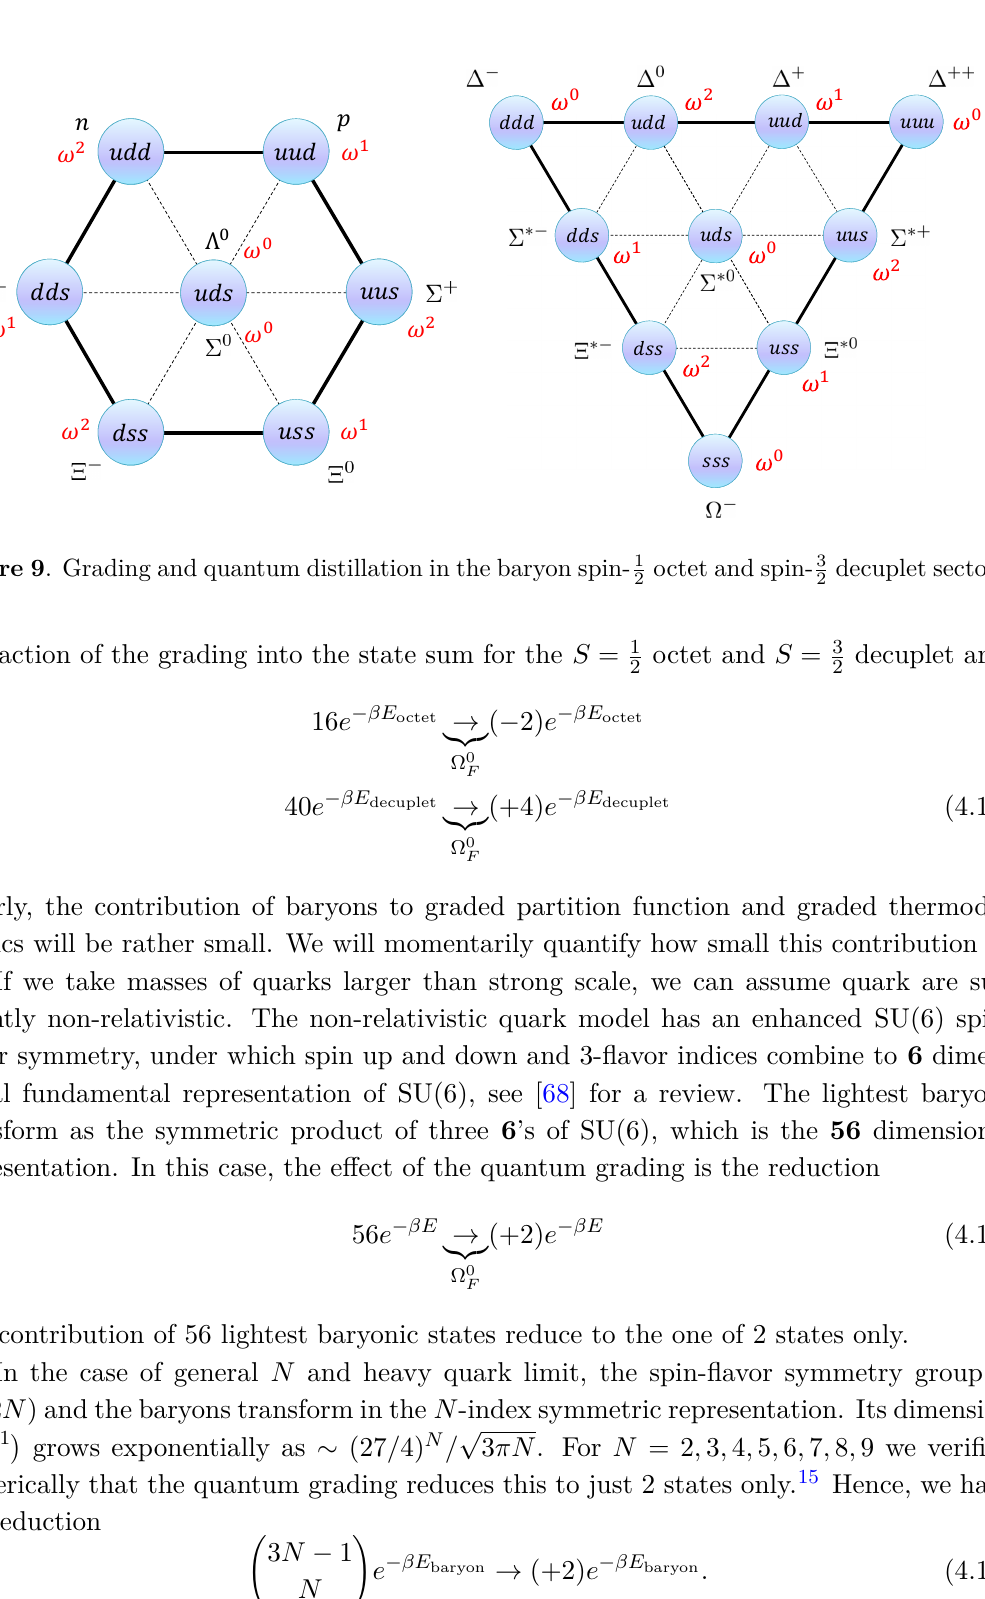
Figure 9 . Grading and quantum distillation in the baryon spin- 1